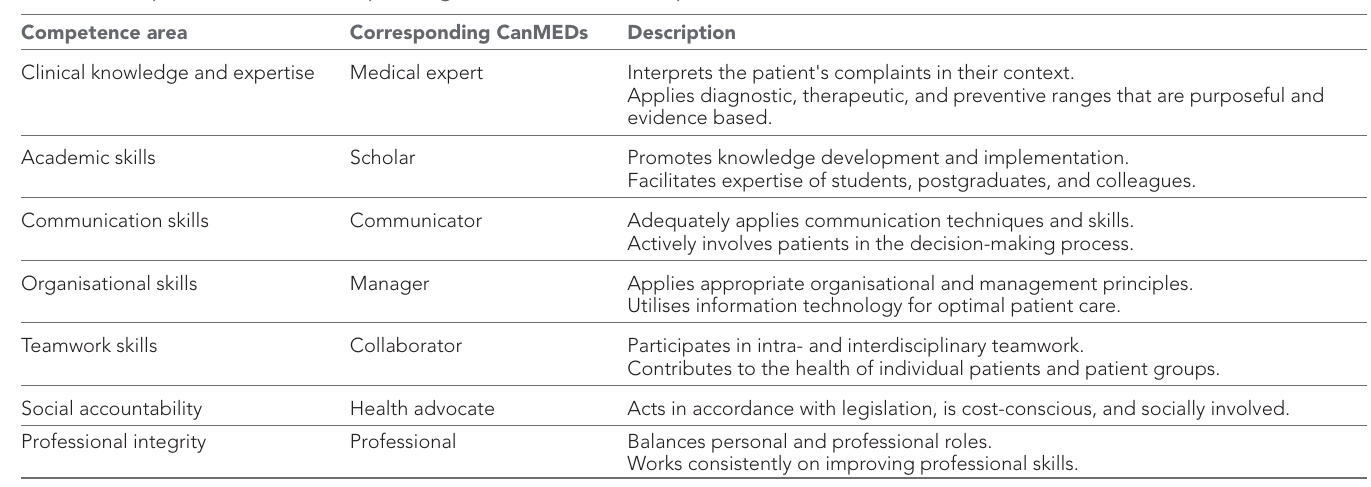
Table 1 Competence areas, corresponding CanMEDs, and